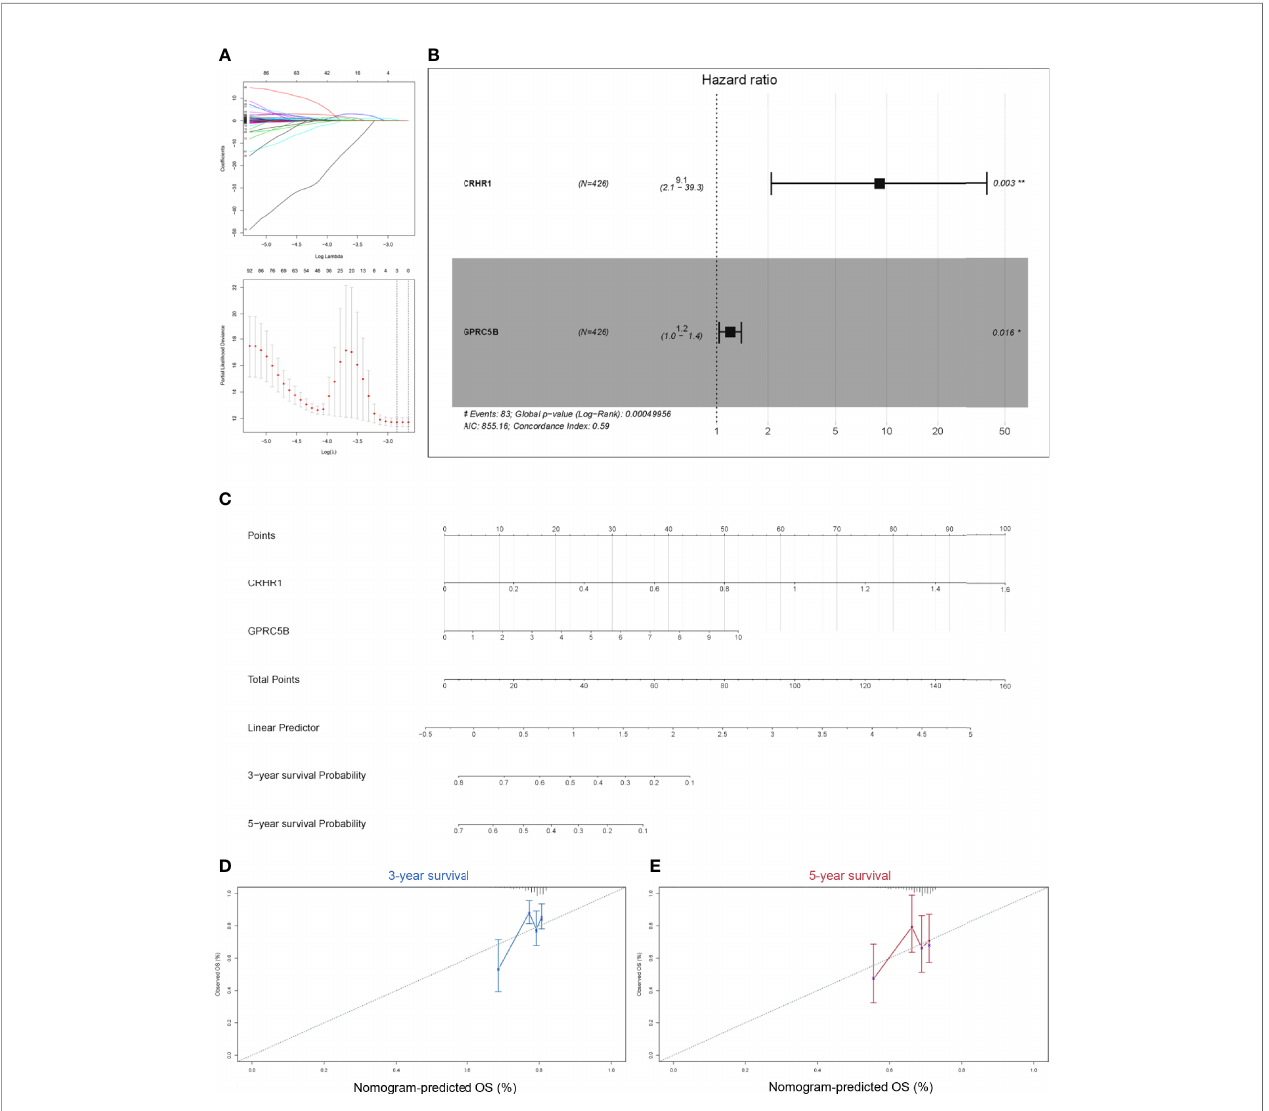
FIGURE 3 | (A) To prevent the bias causedby over fi tting, LASSO regression was applied. (B) Basedonthe LASSO regression results, the reduced multi-Cox regression model was constructed.CRHR1 (p = 0.003) andGPRC5B (p= 0.016)were shownto bepotentially correlated with COAD prognosis. (C) A nomogram basedonthe reduced-Cox model in (B) was constructed(p = 0.0005, AIC = 855.16, C-index = 0.6). (D, E) Calibration curves of 3-year survival (D) and 5-year survival (E) validated the acceptable accuracy of the model.LASSO,least absolute shrinkage andselection operator;CRHR1, corticotropin releasinghormone receptor1; GPRC5B,G protein- coupled receptor class C group 5 member B;COAD, colon